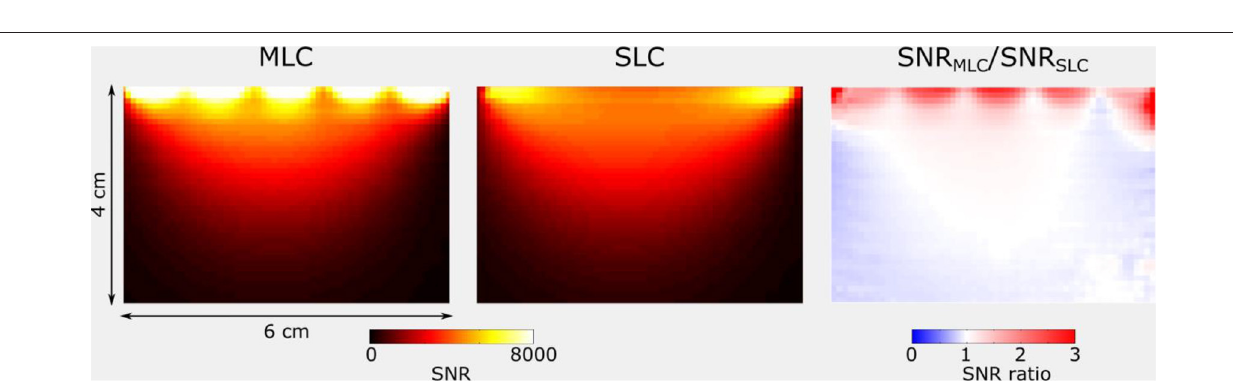
respect to the sample shape, but also the optimization of